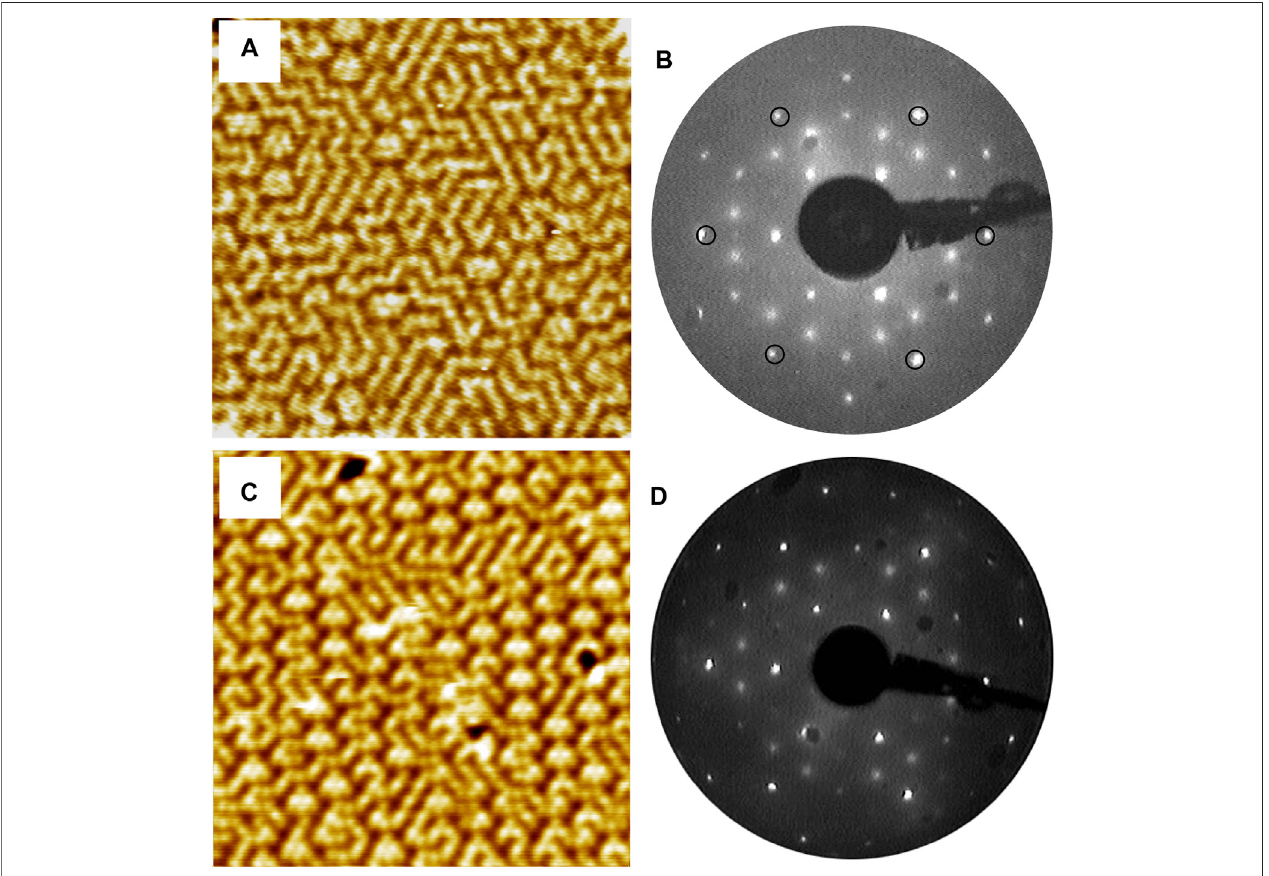
FIGURE 1 | Morphology and arrangement of the PbBi atomic layer adsorbed on different substrates. The Ge(111)-based system is characterised by (A) 25 × 29 nm 2 ( − 1.5 V, 0.9 nA) STM image; (B) 79 eV LEED pattern. The Si(111)-based system is characterised by (C) 15 × 15 nm 2 ( − 0.002 V, 200 pA) STM image; (D) 54 eV LEED pattern, recorded at 78